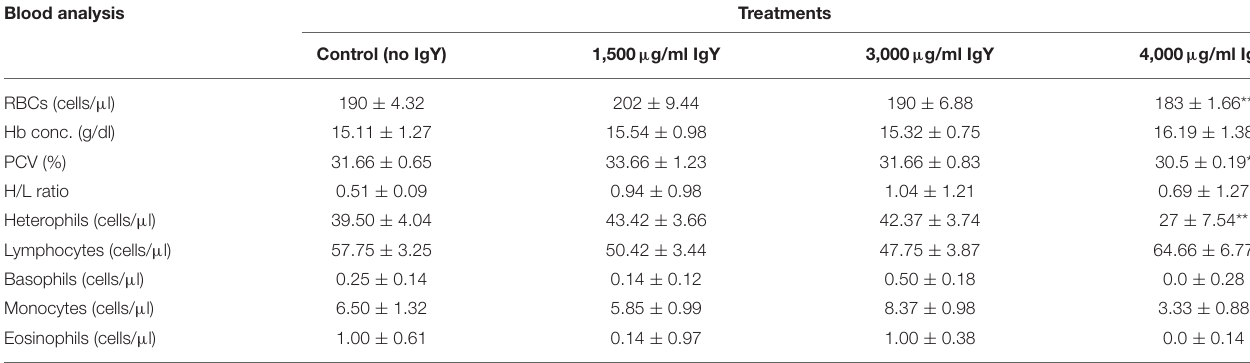
TABLE 6 | Blood parameters of broiler carcasses fed multiple IgY concentrations at day